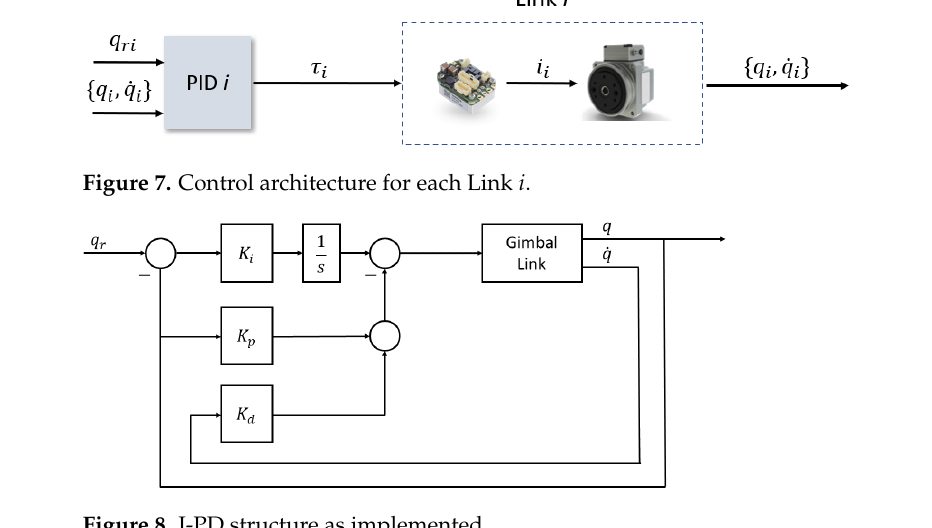
Figure 8. I-PD structure as